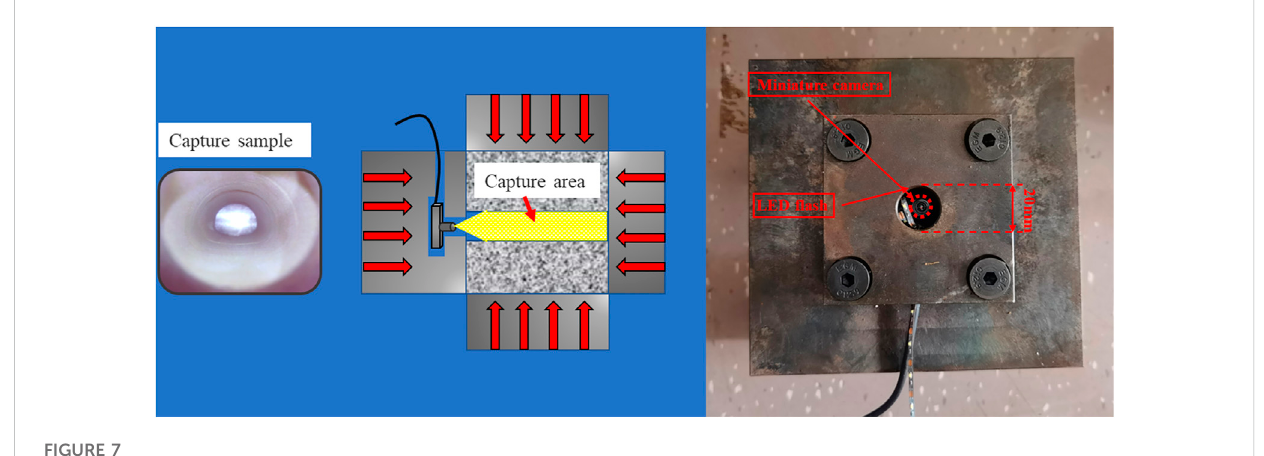
FIGURE 7 Micro cameras and capture